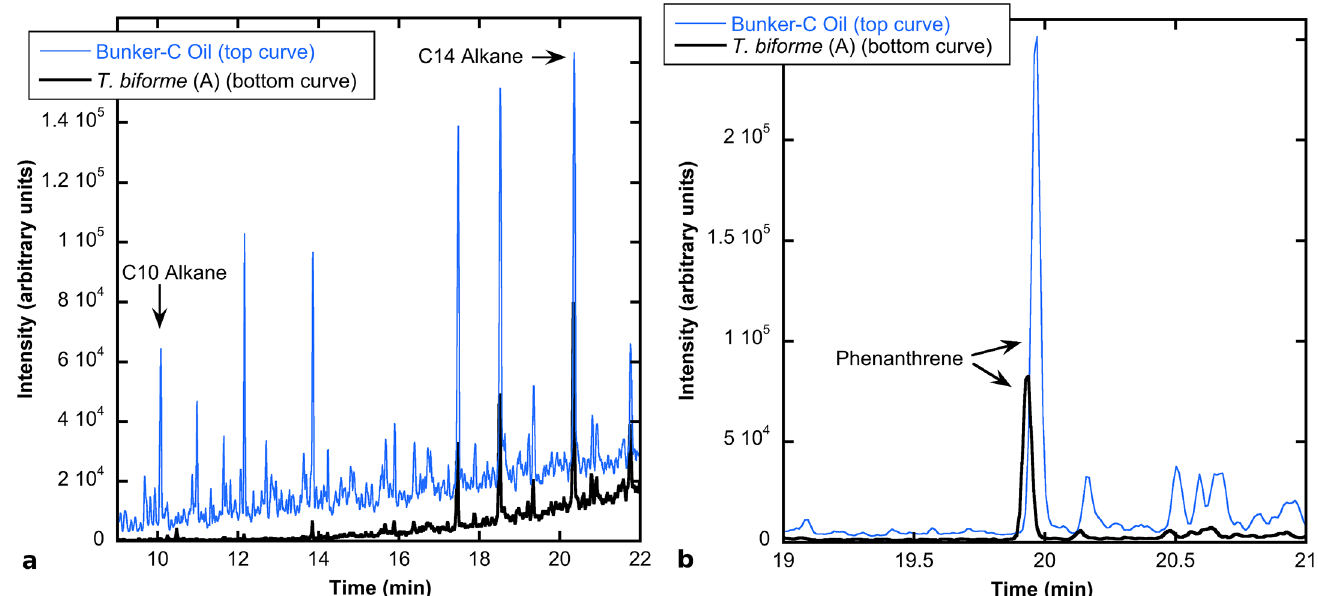
Fig 1. Hydrocarbon degradation by Trichaptum biforme . GC-MS chromatograms of (a) alkane and (b) phenanthrene degradation by T . biforme measured after 180 days of growth in pine media with Bunker C oil. Black lines = T . biforme profiles; blue lines = Bunker C oil profiles.